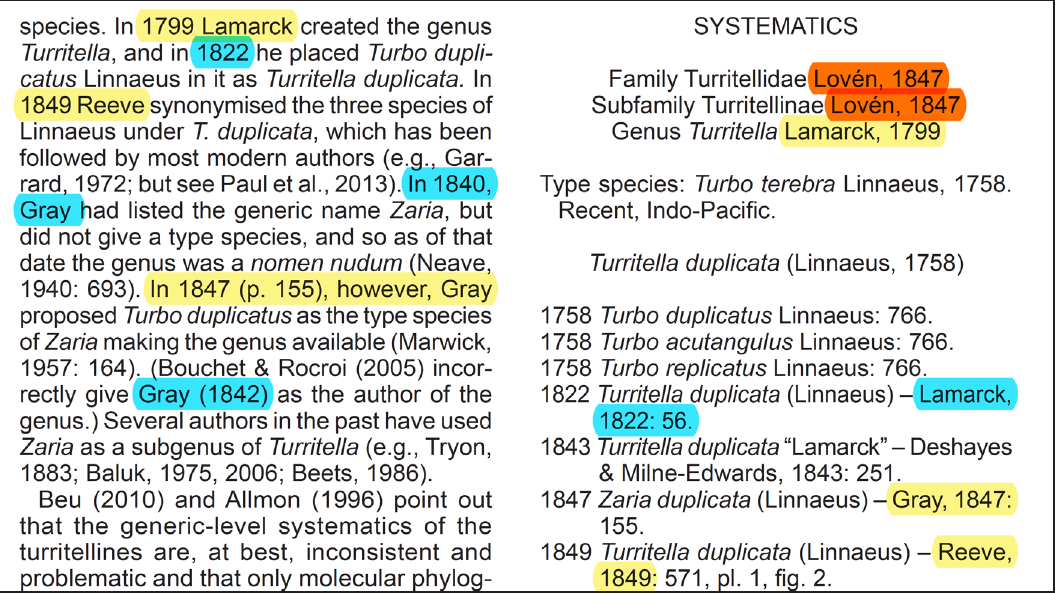
Fig. 6. Authorships formally presented as references, those in yellow are listed in the references section whereas those in orange are not considered as bibliographic references. A . Musavu Moussavou (2017). B . Mendoza-Garfias et al. (2017).